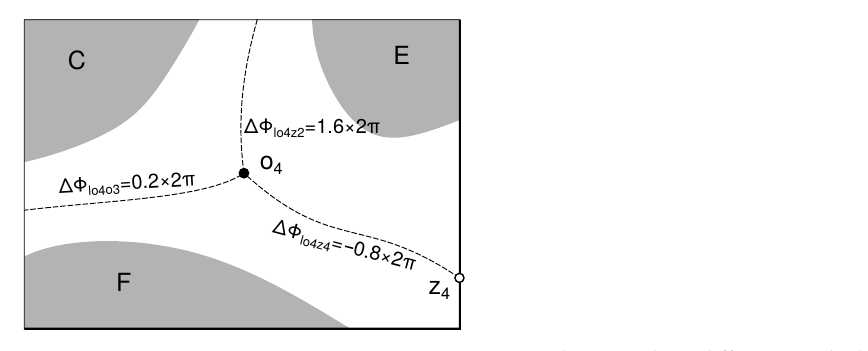
Figure 3. A region corner among continuous regions and region phase differences calculated